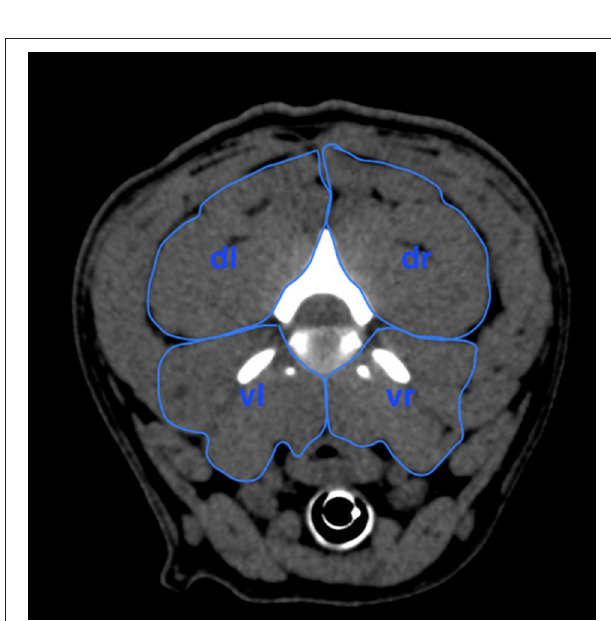
FIGURE 4 | Scheme of measurement of the areas in the four quadrants of the cervical paraspinal musculature at the intervertebral disk level of C2/C3 in transversal plane to calculate area ratio. dr, dorsal right area; dl, dorsal left area; vr, ventral right area; vl, ventral left area.